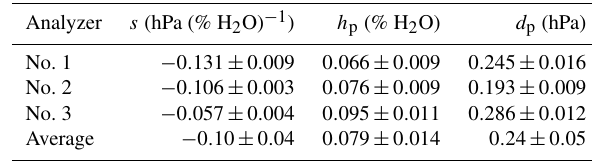
Table 3. Coefficients of the empirical cavity pressure model Eq. (4) for data from experiments with stable water vapor levels and exter- nal pressure monitoring (estimate and standard error). The last line shows averages and standard deviations of the individual